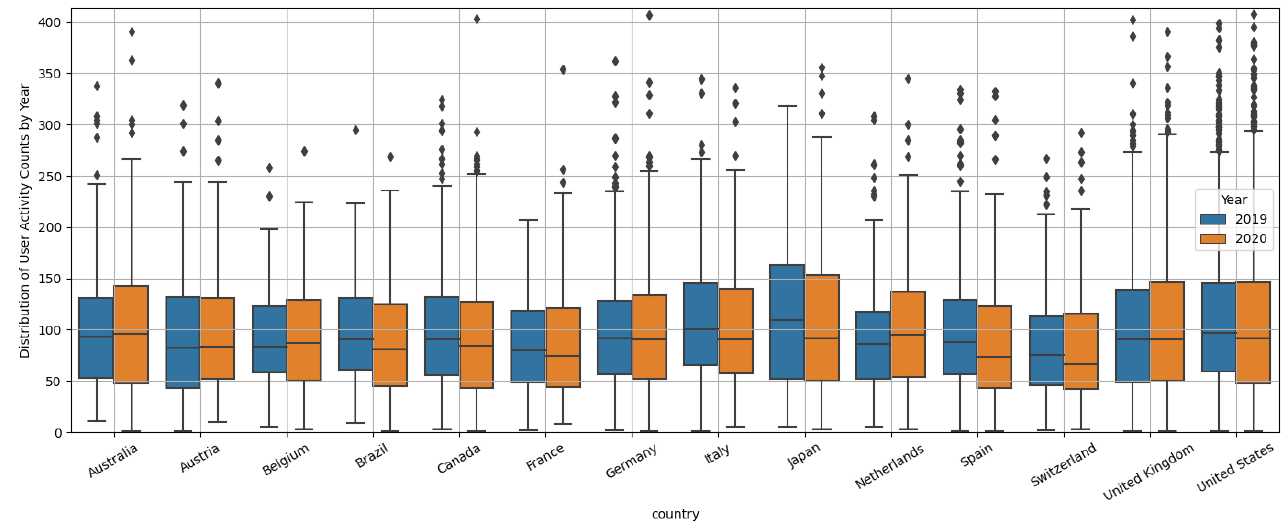
Figure 2. Distribution of user activity counts broken down by country and